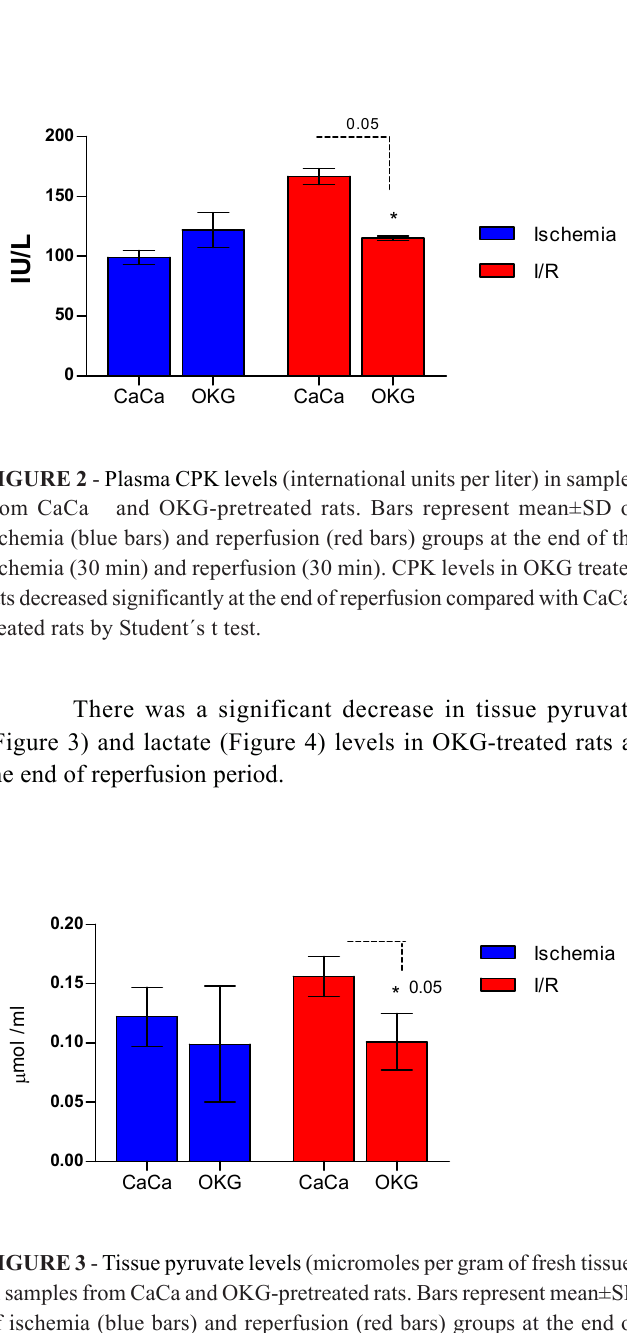
FIGURE 1 - Plasma CPK levels (international units per liter) in samples from CaCa and OKG-pretreated rats. Bars represent mean±SD at different timepoints in rats subjected to surgical trauma (laparotomy). CPK levels in OKG and in CaCa-treated rats were not different by ANOVA test.